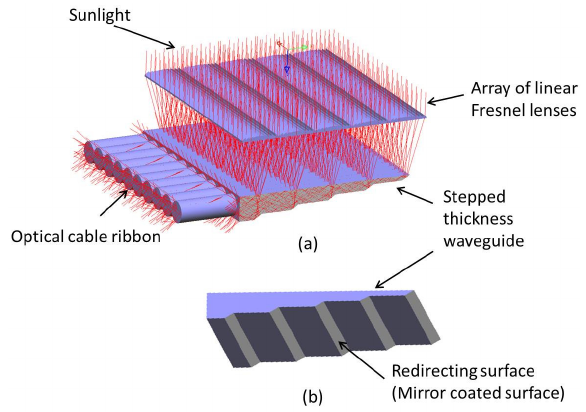
Figure 2. ( a ) Physical layout of optical fiber daylighting system, using linear Fresnel lens array and stepped thickness waveguide; ( b ) Detail of stepped thickness waveguide from bottom view.